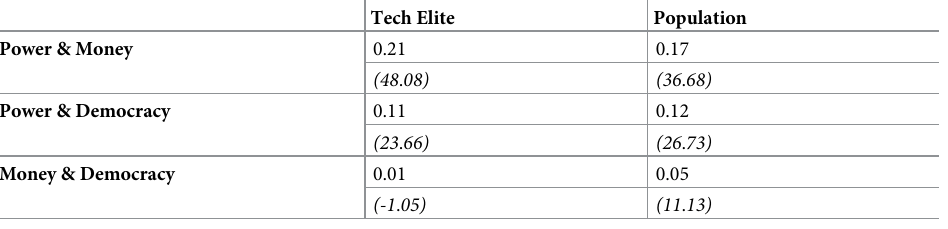
Table 1. Correlation between democracy, power and money in tweets of the tech elite and the US Twitter